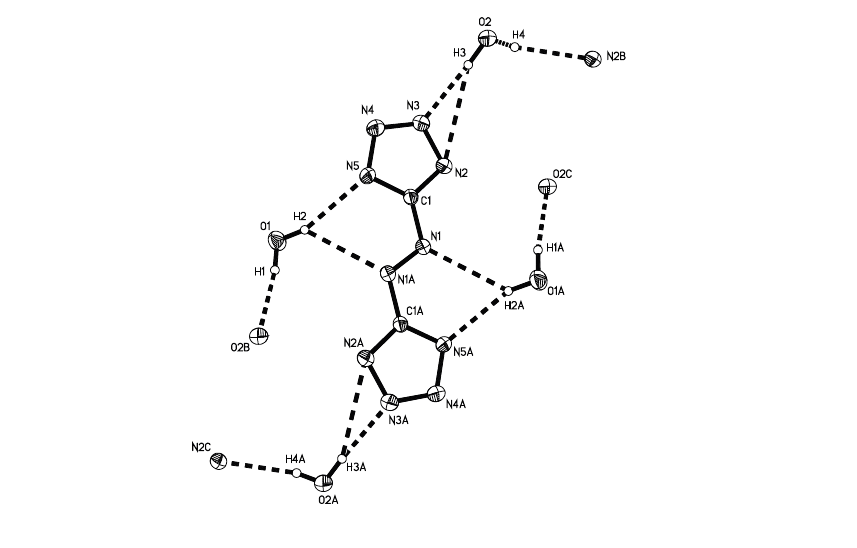
Figure 5. Hydrogen bonding between the 5,5'-azotetrazolate dianions and the water of crystallization in the crystal struture of 1 . Table 2. Hydrogen bond lengths [Å] in 1